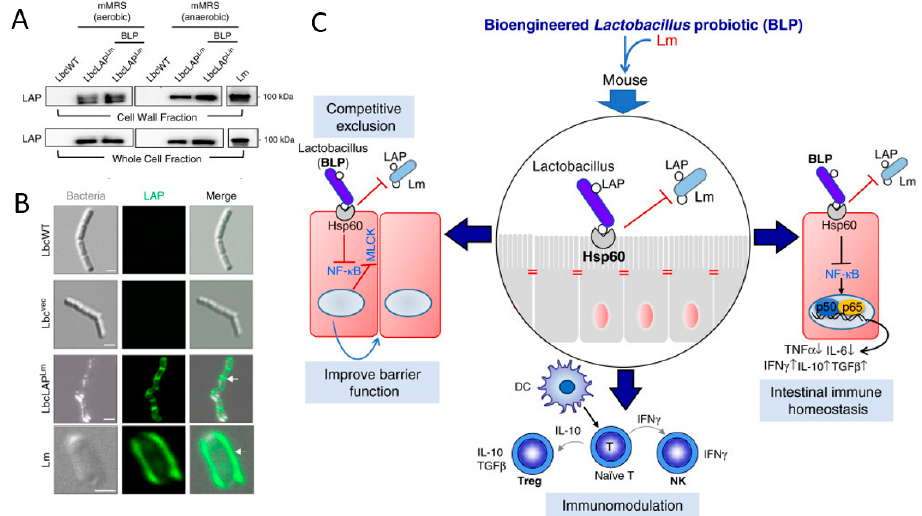
Figure 6. Engineered Lactobacillus for treating Listeria infection. ( A ) Detection of the expression of LAP from Listeria by western blot, showing LAP presenting in both the cell wall and whole-cell fractions of engineered Lactobacillus strains. ( B ) Immunofluorescence images of LAP expressed successfully on the surface of engineered Lactobacillus . ( C ) Schematic illustration of the mechanism for the protection effect of engineered Lactobacillus against listeriosis . Adapted with permission from [57]; published by Springer Nature, 2020.